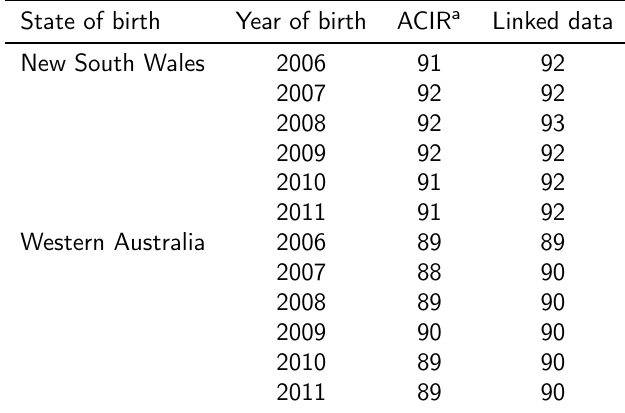
Table A3: Percentage of children immunised by 12 months of age with the 3rd dose of pneumococcal conjugate vaccine by birth cohort, data source, and state of birth